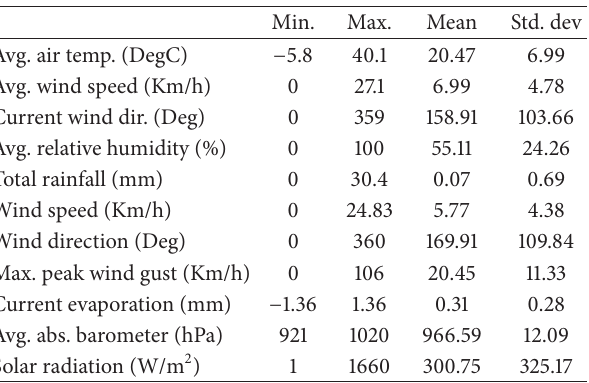
Table 1: Statistical description of the raw data set. Min.